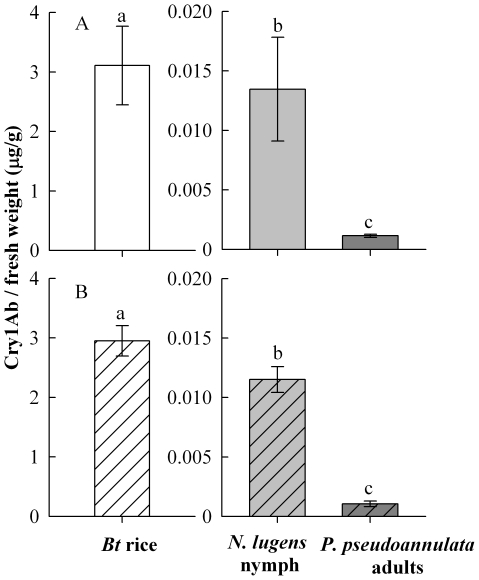
Levels of Cry1Ab protein (mean ± SE) detected from Bt rice and Bt rice-reared Nilaparvata lugens nymphs, and Pardosa pseudoannulata adults fed on Bt rice-fed N. lugens larvae using ELISA.(A) KMD1, (B) KMD2. n = 5 for Bt rice and Nilaparvata lugens nymphs; n = 3 for Pardosa pseudoannulata adults. Means denoted with different lowercase letters were significantly different (one-way ANOVA, P<0.05). Note difference in scale for Cry1Ab concentrations in plants and insects.